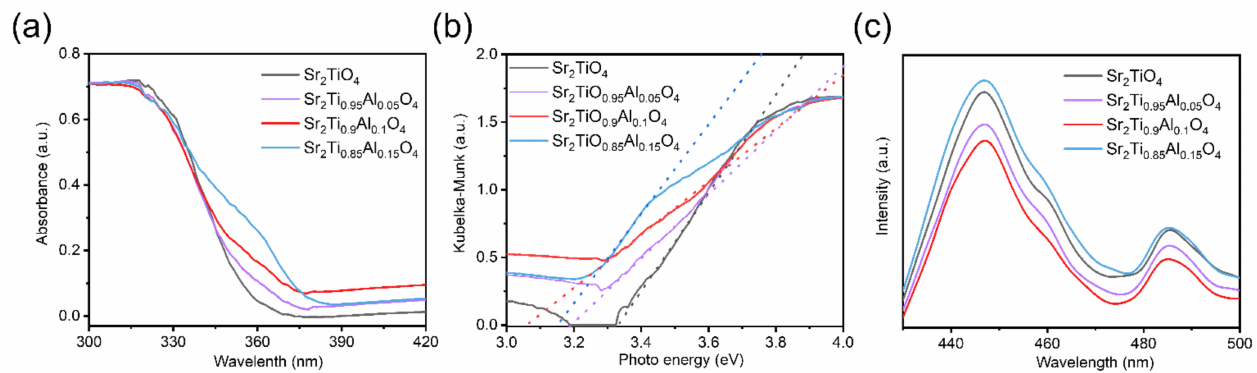
Figure 5. ( a ) UV-vis diffuse reflectance spectra, ( b ) Kubelka–Munk curves and ( c ) PL spectra of Sr 2 Ti 1 − x Al x O 4 (x = 0, 0.05, 0.1, and